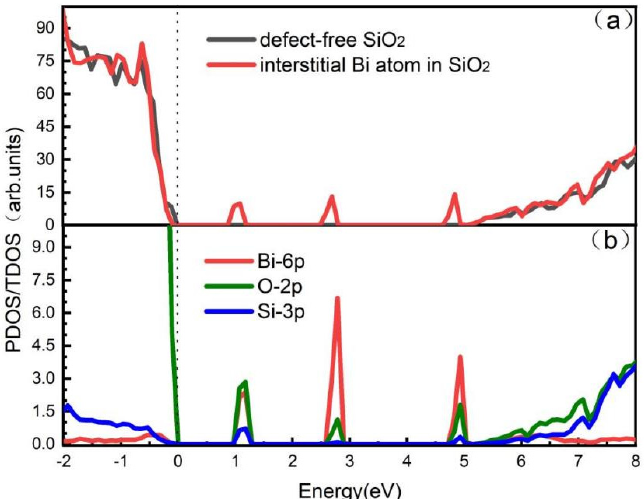
Figure 2. ( a ) Black represents the total electronic density of states of defect-free silica fiber, and red represents the total electronic density of states of bismuth-doped silica fiber. ( b ) Red represents the 6p orbital of bismuth atom, green represents the 2p orbital of oxygen atom, and blue represents the 3p orbital of silicon atom.